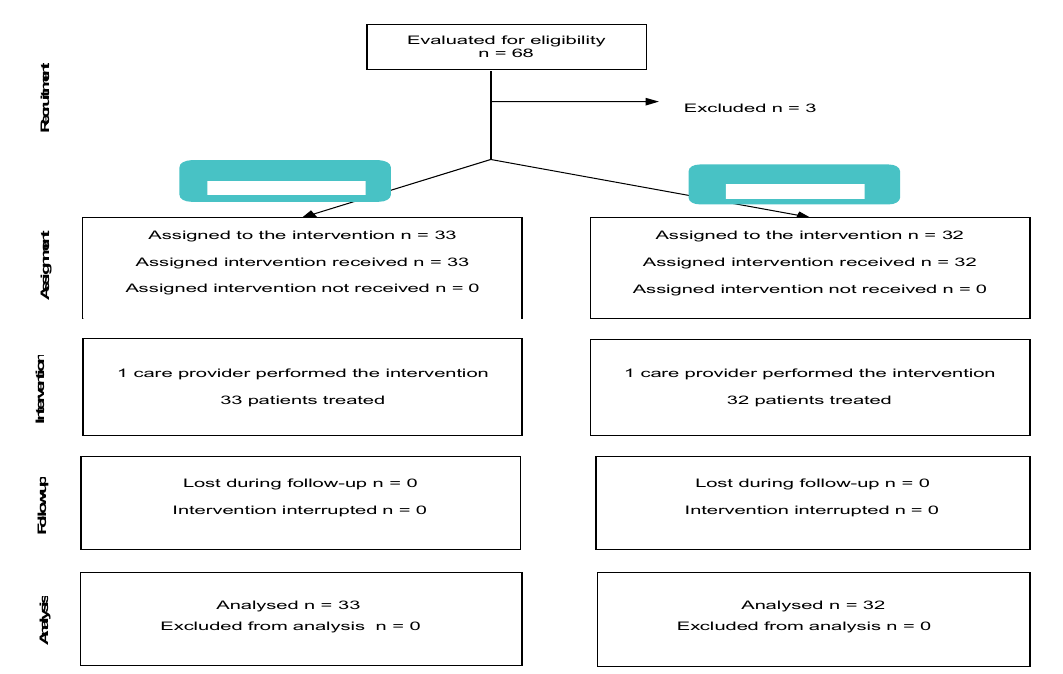
Figure 1. Study flowchart